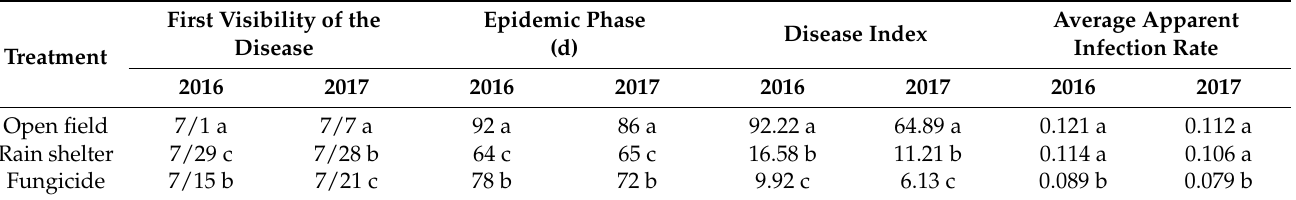
Table 1. Characteristics of grape downy mildew (GDM) under the open-field, rain-shelter, and fungicide-managed plots in Shenyang (2016–2017).